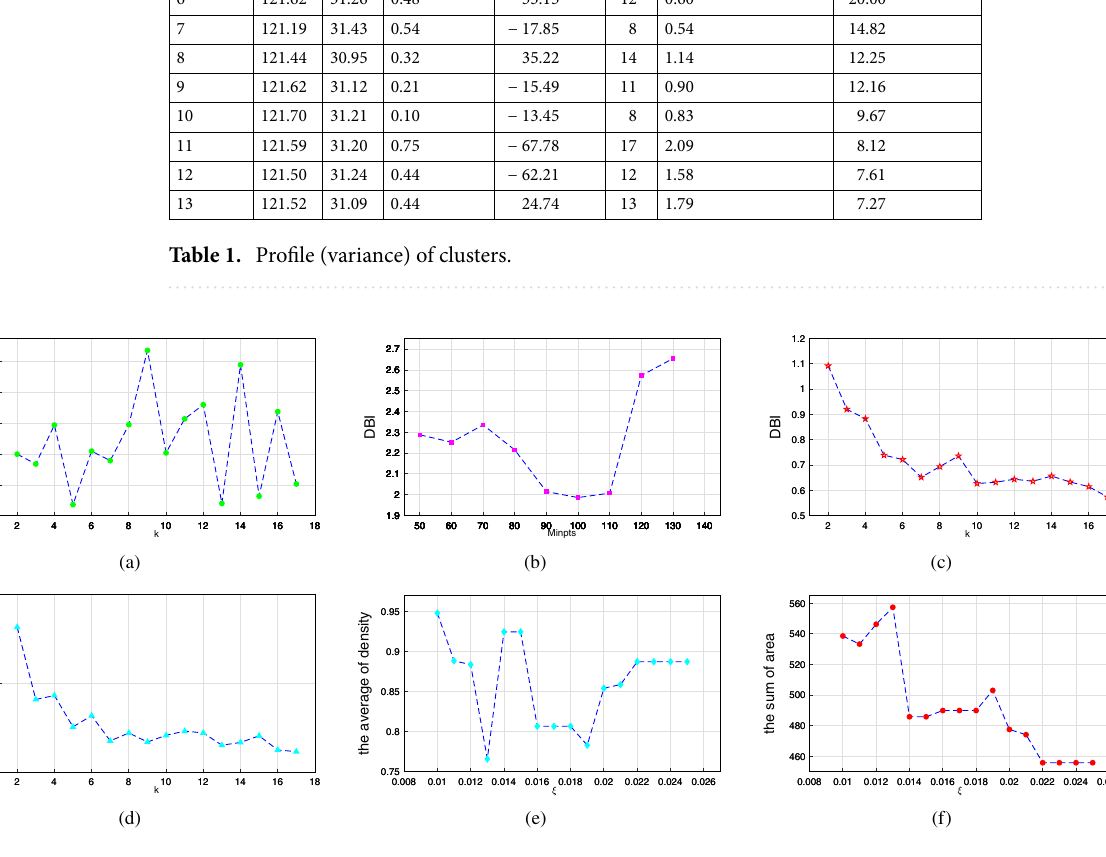
Figure 3. Similarity measure under different parameters: ( a ) optimal k through DBI (GMM-EMM1), ( b ) optimal MinPts through DBI (DBSCANM2, ε = 0.015), ( c ) optimal k through DBI (complete-linkM3), ( d ) optimal k through DBI (K-meansM4), ( e ) optimal ξ through the average of density (EBC), ( f ) optimal ξ through the sum of area (EBC).